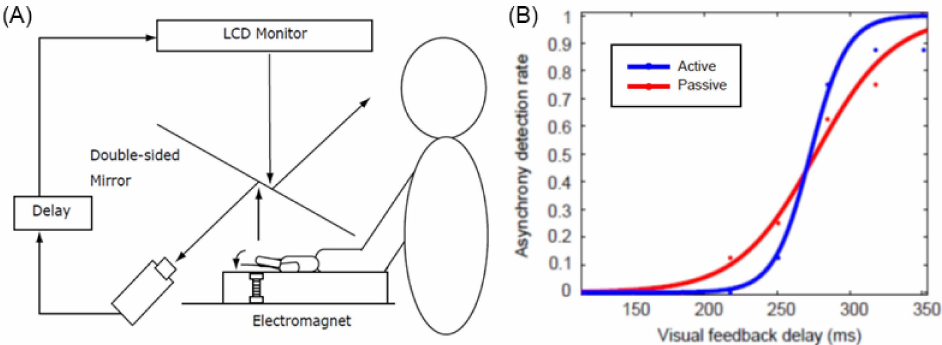
Figure 2. Active and passive vision-movement asynchrony judgement task [14]. ( A ) experimental settings. ( B ) A representative result. The time window for detecting visual feedback delay is nearly equivalent for active and passive movements, while the steepness of the slope is steeper for active movement than for passive